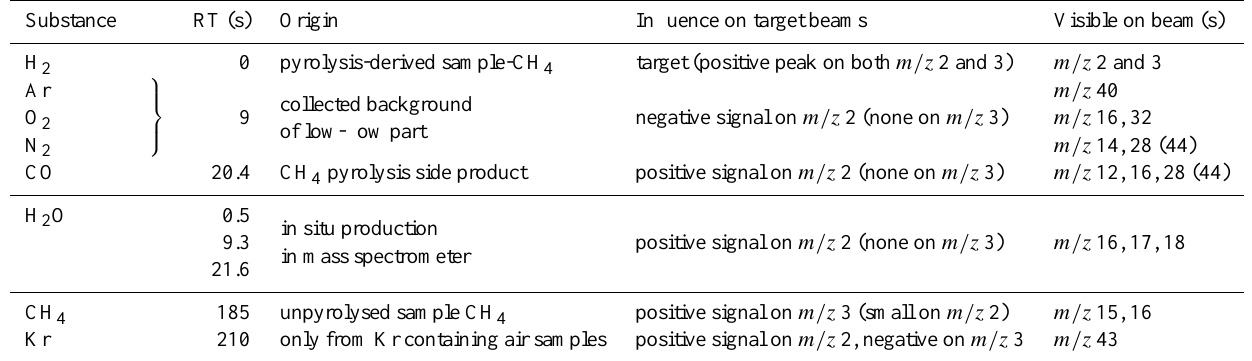
Table 2. Sequence of detected species using the 2014 set-up (Fig. 1 and Table 1). Retention time (RT) is given relative to the H 2 peak Table 4. Sequence of detected species using the 2014 set-up (green in Table 1 and Figure 1). Retention time maximum. Ar, O 2 and N 2 are not well-separated from each other under the described conditions. For CH 4 and Kr, the start of peaks is given, (RT) is given relative to the H 2 peak maximum. Ar , O 2 and N 2 are not well-separated from each other under as the two substances elute very broadly from the cooled PLOT column. H 2 O does not enter the mass spectrometer but is produced in situ the described conditions. For CH 4 and Kr the start of peaks is given, as the two substances elute very broadly (see text). from the cooled PLOT column. H 2 O does not enter the mass spectrometer but produced in situ (see